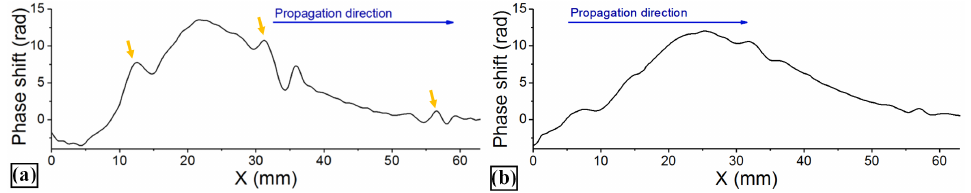
Figure 4. Reconstructed profiles of strain waves in the polystyrene bar in the areas of 50–110 mm ( a ) and 100–160 mm ( b ) from the bar input. Yellow arrows in the graph ( a ) indicate fast-decaying short-wavelength oscillations.